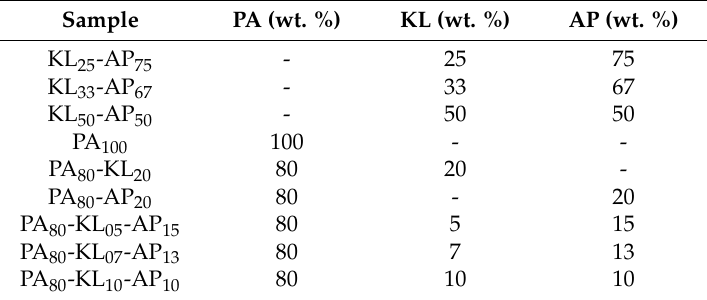
Table 1. Blend formulations: kraft lignin (KL)-ammonium polyphosphate (AP) powder mix and polyamide 11 (PA)